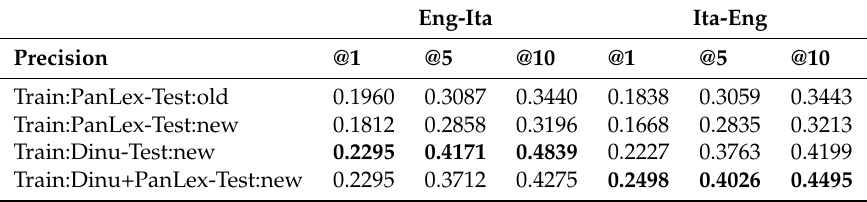
Table 10. Comparing Dinu’s and PanLex data on the PanLex test set.